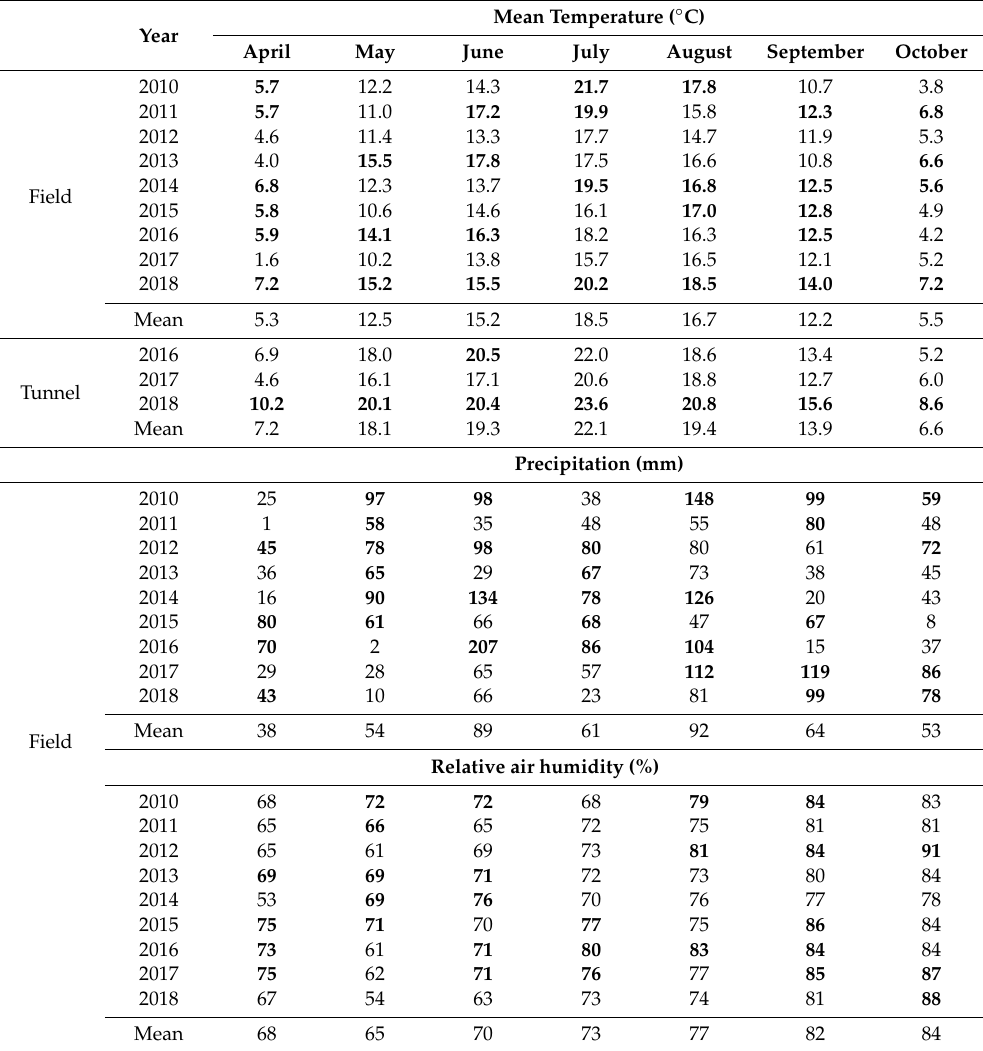
Table 2. Monthly temperatures, precipitation and relative air humidity from April to October in the years from 2010 to 2018 in field conditions and the monthly temperatures in tunnel from 2016 to